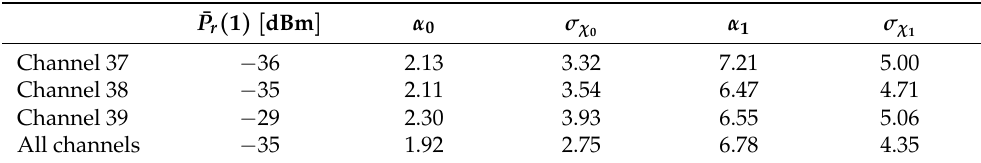
Figure 17. Two-segment path loss models derived using the median of six random data samples from each of the six receivers. Table 4. Two-segment path loss model parameter values derived using the median of six random data samples from each of the six